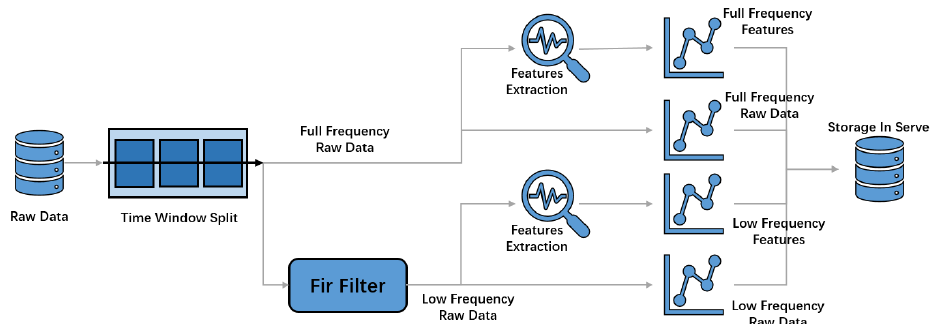
Figure 3. Workflow of the process of AETA raw data.